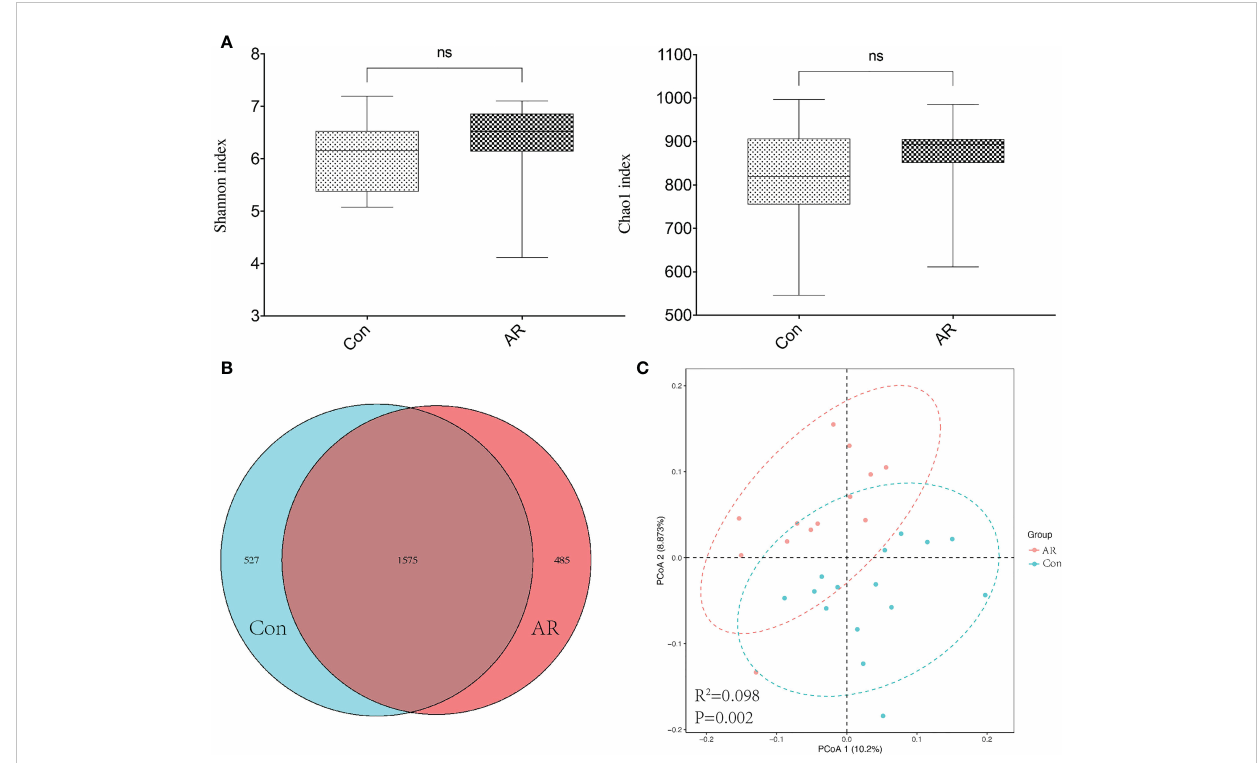
FIGURE 3 Diversity of gut microbiota in AR vs. Con groups. (A) The Chao1 and Shannon index; (B) Venn based on OTUs in AR vs. Con groups; (C) Principal coordinates analysis (PCoA). Dots of the same color represent each biological repetition in the group, and the distribution state of dots re fl ects the difference between and within the group. Con group(n=15) vs AR group(n=13). ns: P >